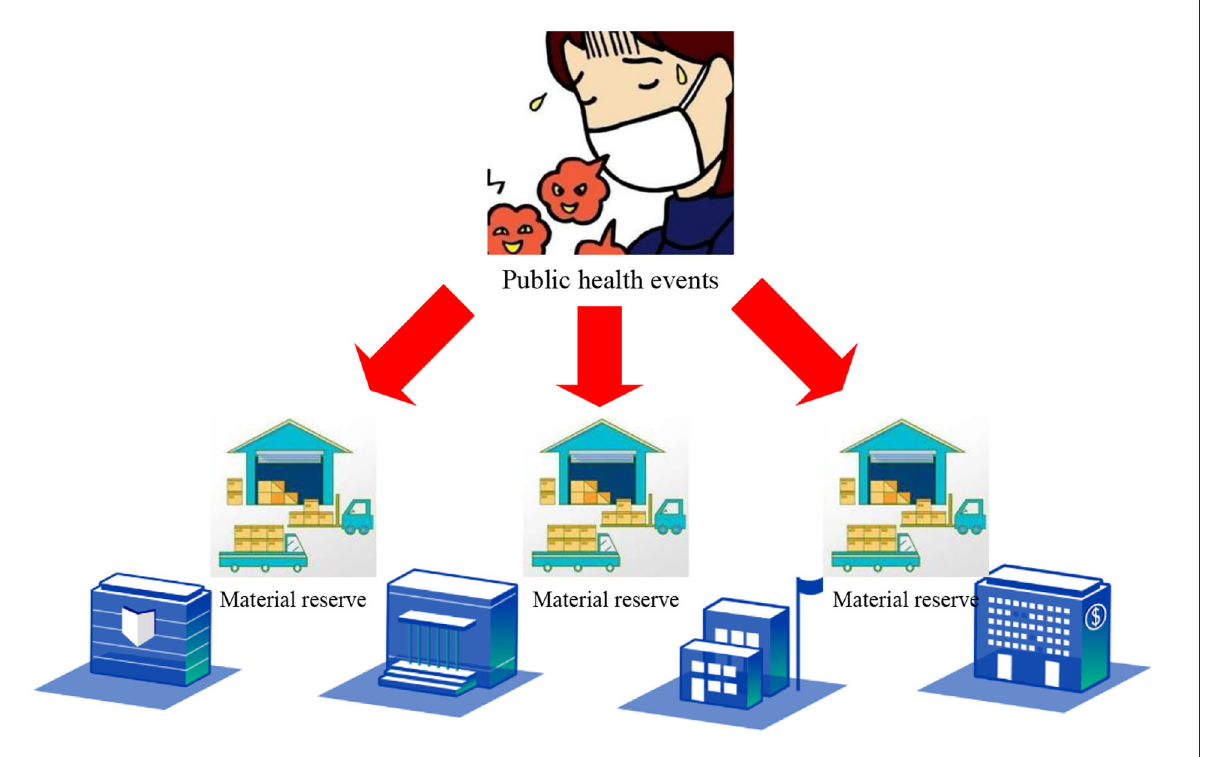
FIGURE1 Full coverage of emergency materials